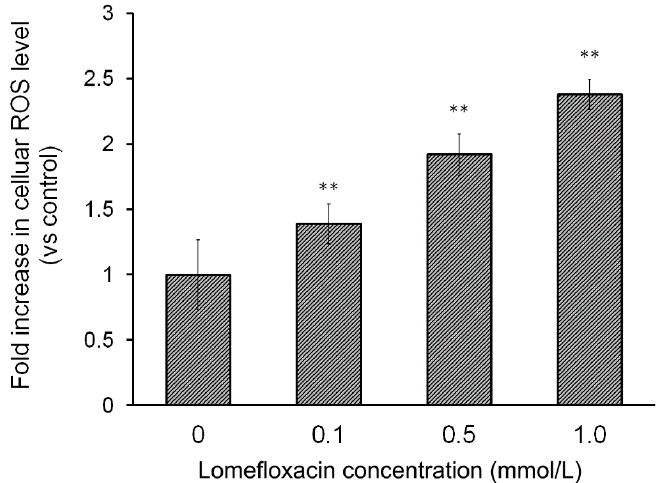
Figure 3. Lomefloxacin induces reactive oxygen species (ROS) production in COLO829 melanoma cells. The cells were exposed to the drug in concentrations of 0.1, 0.5, and 1.0 mmol/L for 24 h. The data are expressed as percentages of the controls normalized to a number of living cells. Mean values ± SEM from three independent experiments ( n = 3) performed in triplicate are presented. ** p < 0.005 versus control samples.